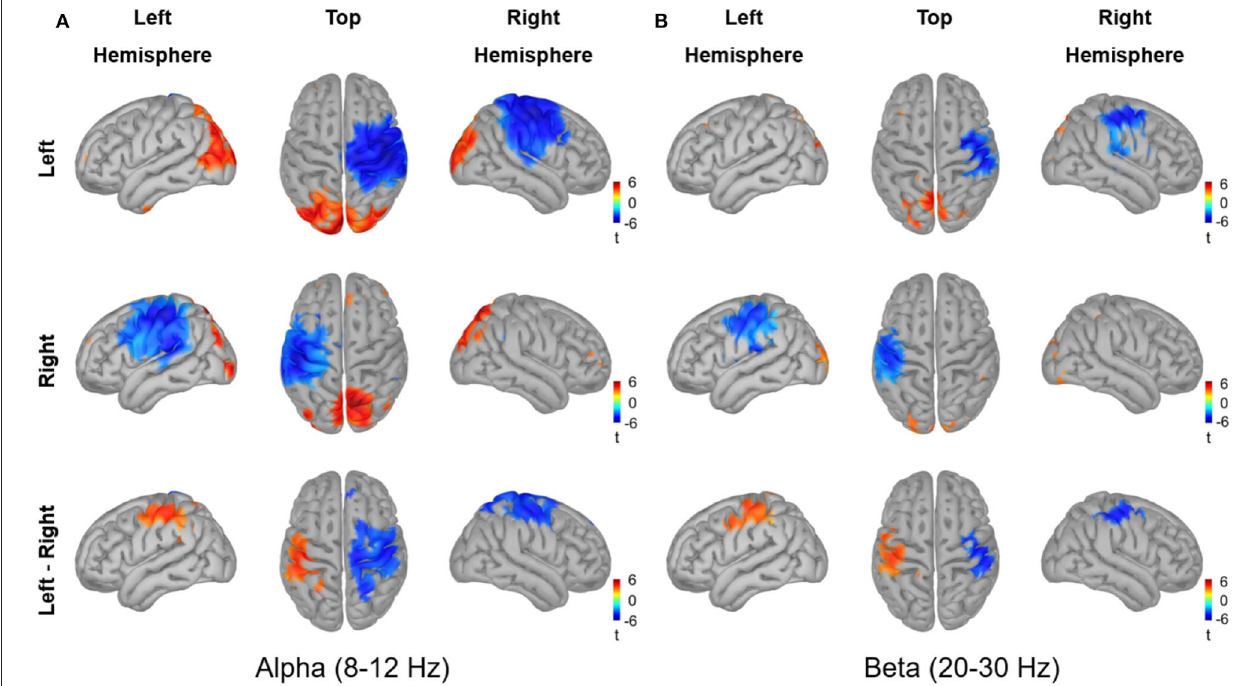
FIGURE 9 | Source reconstruction of the oscillatory activities in the alpha band (8–12 Hz) and in the beta band (20–30 Hz) induced by vibrotactile stimulation. The grand averaged oscillatory power changes (A) in the alpha band (8–12 Hz) and (B) in the beta band (20–30 Hz) are presented in simultaneous views from the left hemisphere, top, and the hemisphere. The dB transformed spectral power relative to the baseline ( − 0.4 to − 0.2 s) was averaged over an active period between 0.2 and 0.4 s after stimulus onset, and then statistically tested for the significance using a permutation paired t -test (10,000 randomizations, α = 0.01, FDR corrected). The statistical t-maps of areas showing significant power change in the active period relative to the baseline are plotted for the left index finger stimulation condition (top panel) and for the right index finger stimulation condition (middle panel), respectively. In the lower panel, the statistical t-maps of areas showing significant differences between left and right stimulation conditions are plotted, with the blue color indicating lower activity for the left index finger stimulation compared with the right index finger